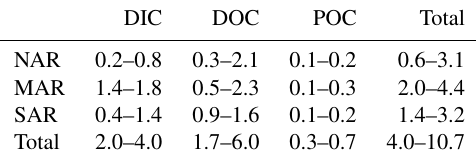
Table 1. Estimates of total annual riverine input from water- sheds to estuaries (Tg Cyr − 1 ) . The ranges are based on Stets and Striegl (2012), Global NEWS (Mayorga et al., 2010), Hartmann et al. (2009), SPARROW (Shih et al., 2010), and DLEM (Tian et al., 2010, 2012). Modified from Najjar et al.